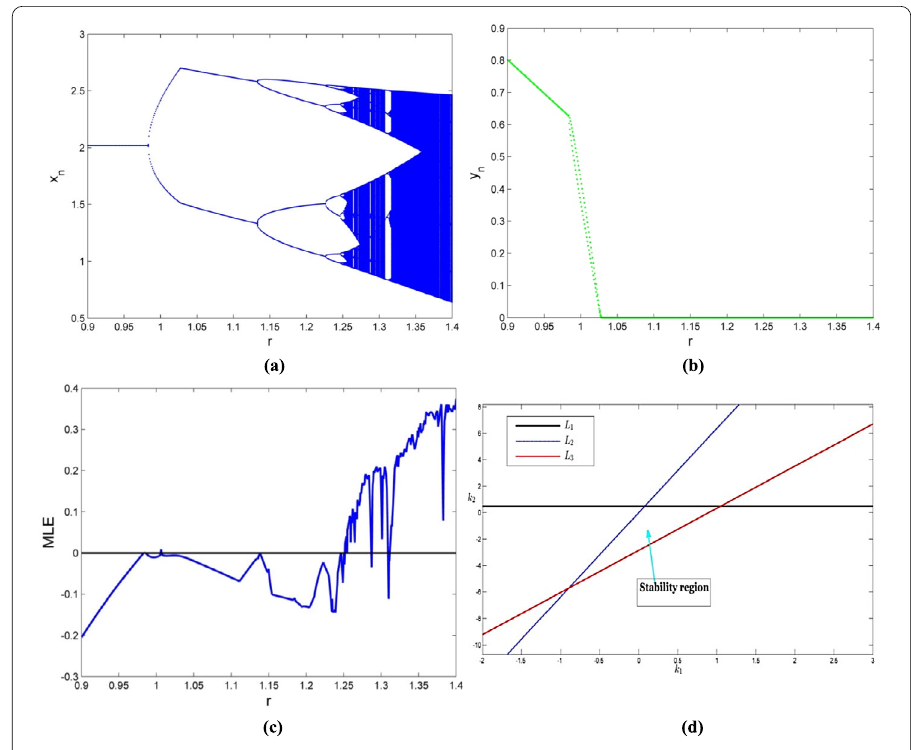
Figure 2 Bifurcation and MLE diagrams for system (4) along with parameters α = 1.02, β = 0.2, γ = 0.1, m = 2.2, b = 2.5, c = 0.01, d = 0.5, r ∈ [0.9,1.4], and ( x 0 , y 0 ) = (2.01,0.6): ( a ) Bifurcation diagram for x n ( b ) Bifurcation diagram for y n ( c ) MLE ( d ) Region of stability for system